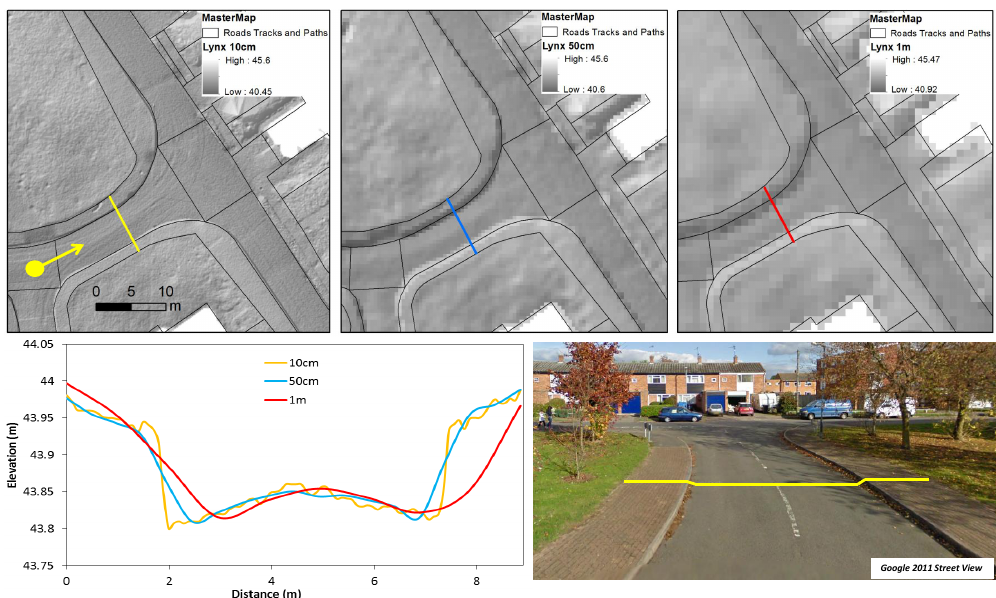
Fig. 3. Google street view and street cross-sections showing the variation in kerb and road surface camber representation on the 10cm and derived 50cm and 1m terrestrial DEMs.